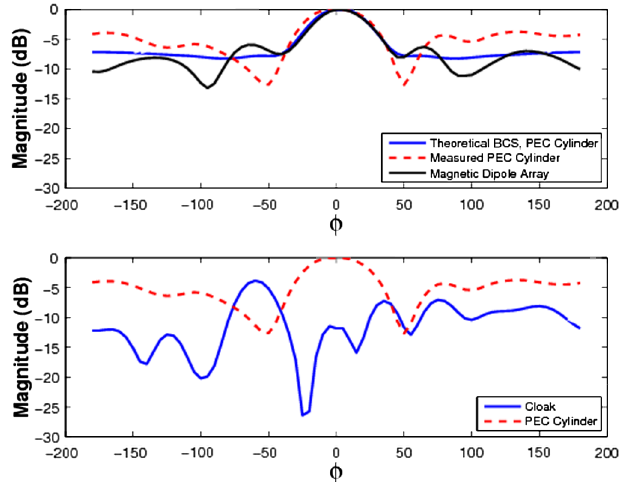
FIG. 9. The calculated BCS patterns for various scenarios. The upper plot shows the measured BCS for the bare aluminum cylinder, the magnetic-dipole array, and the theoretical BCS for a PEC cylinder. The lower plot shows the measured BCS for the bare aluminum cylinder and the active